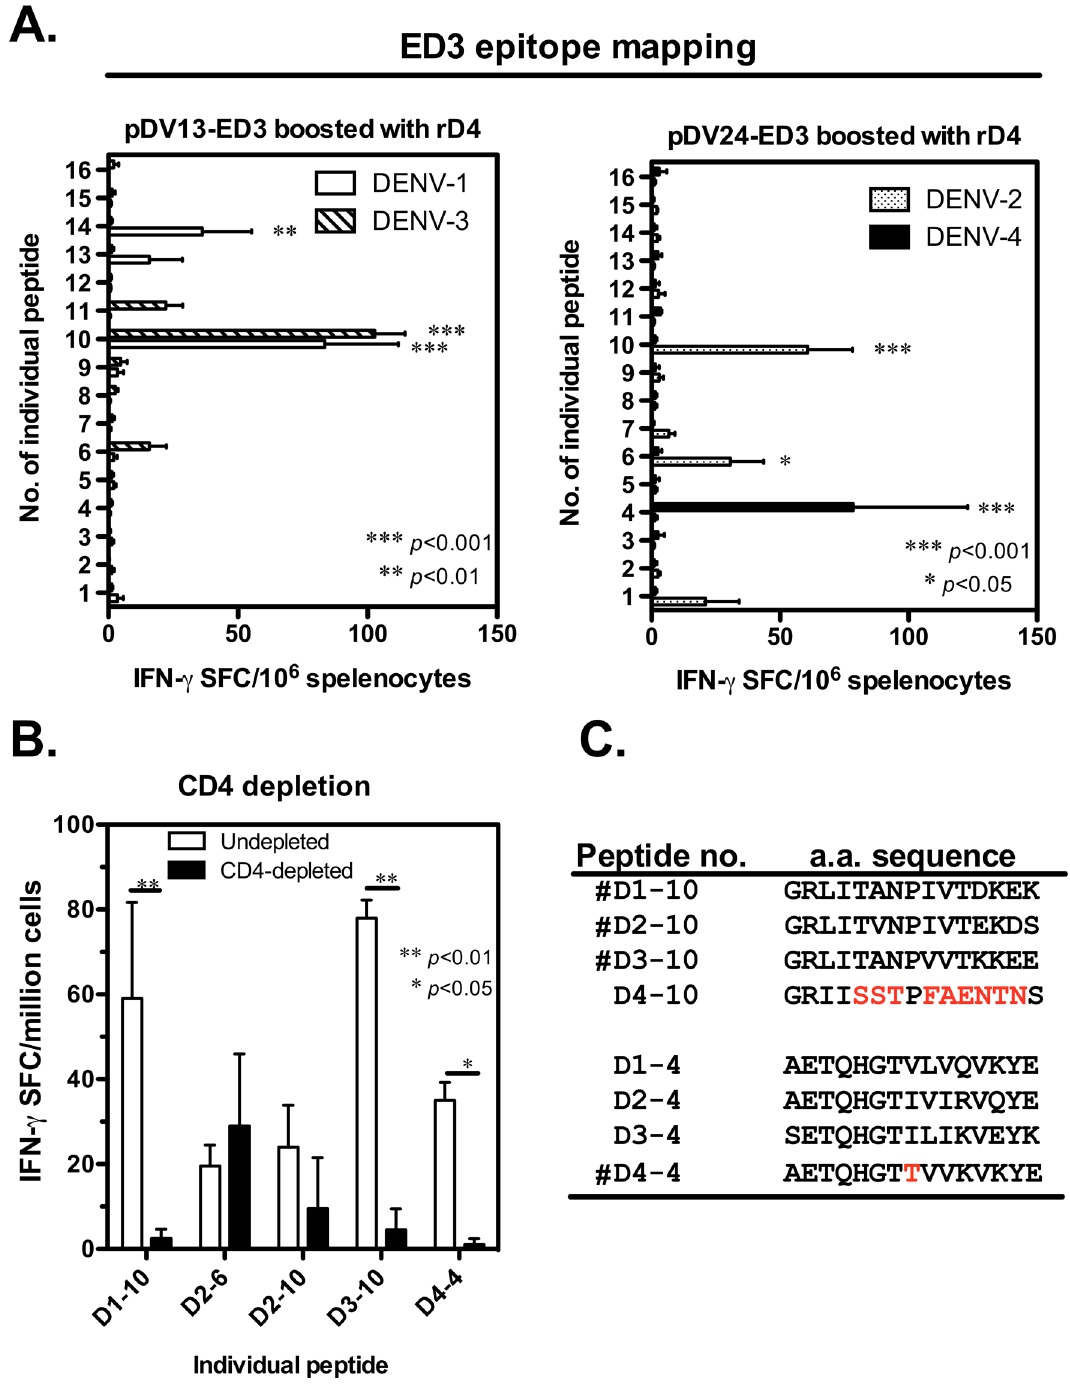
Fig 4. ED3-specific T-cell epitope mapping. Mice (n = 4 per group) were immunized with either pDV13-ED3 or pDV24-ED3 and boosted with recombinant DENV-4 ED3 (rD4) with alum 2 weeks later. (A) Spleen cells were harvested 1 week after the boost, and T-cell epitopes were mapped using IFN- γ ELISPOT. The mean and SD of IFN- γ SFC per million cells responding to sixteen individual peptides for each serotype ED3 are shown. The significance shown in the graph was determined in comparison to other individual peptides. (B) Part of spleen cells were treated with anti-CD4 antibody conjugated with magnetic beads (MACs) for CD4 + cells depletion or were left untreated to analyze the CD4 dependence of specific IFN- γ response by ELISPOT. The mean and SD of IFN- γ SFC per million cells with or without CD4-depletion are indicated. (C) The amino acid sequences of ED3 peptide number 10 (E 349-363 ) and 4 (E 313-327 ) from DENV-1 to 4 are